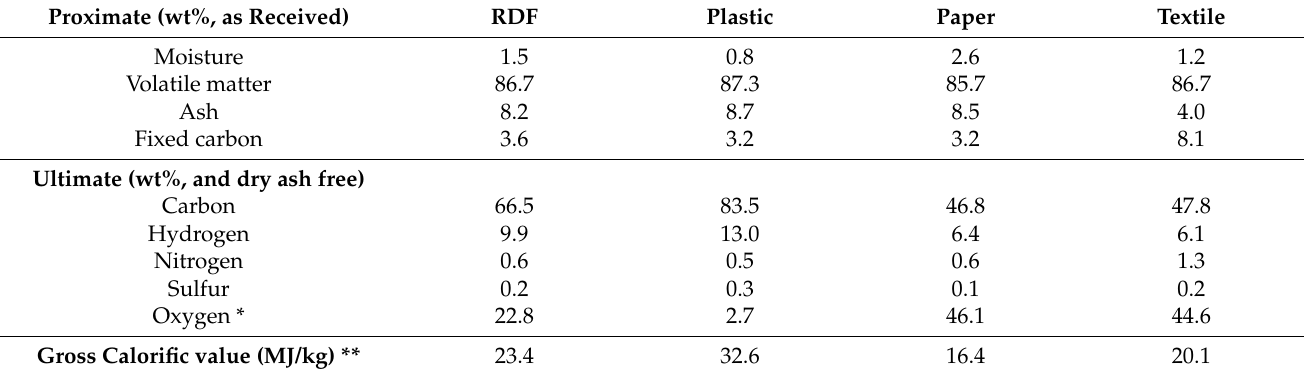
Table 2. Proximate analysis, ultimate analysis, and calorific values of the